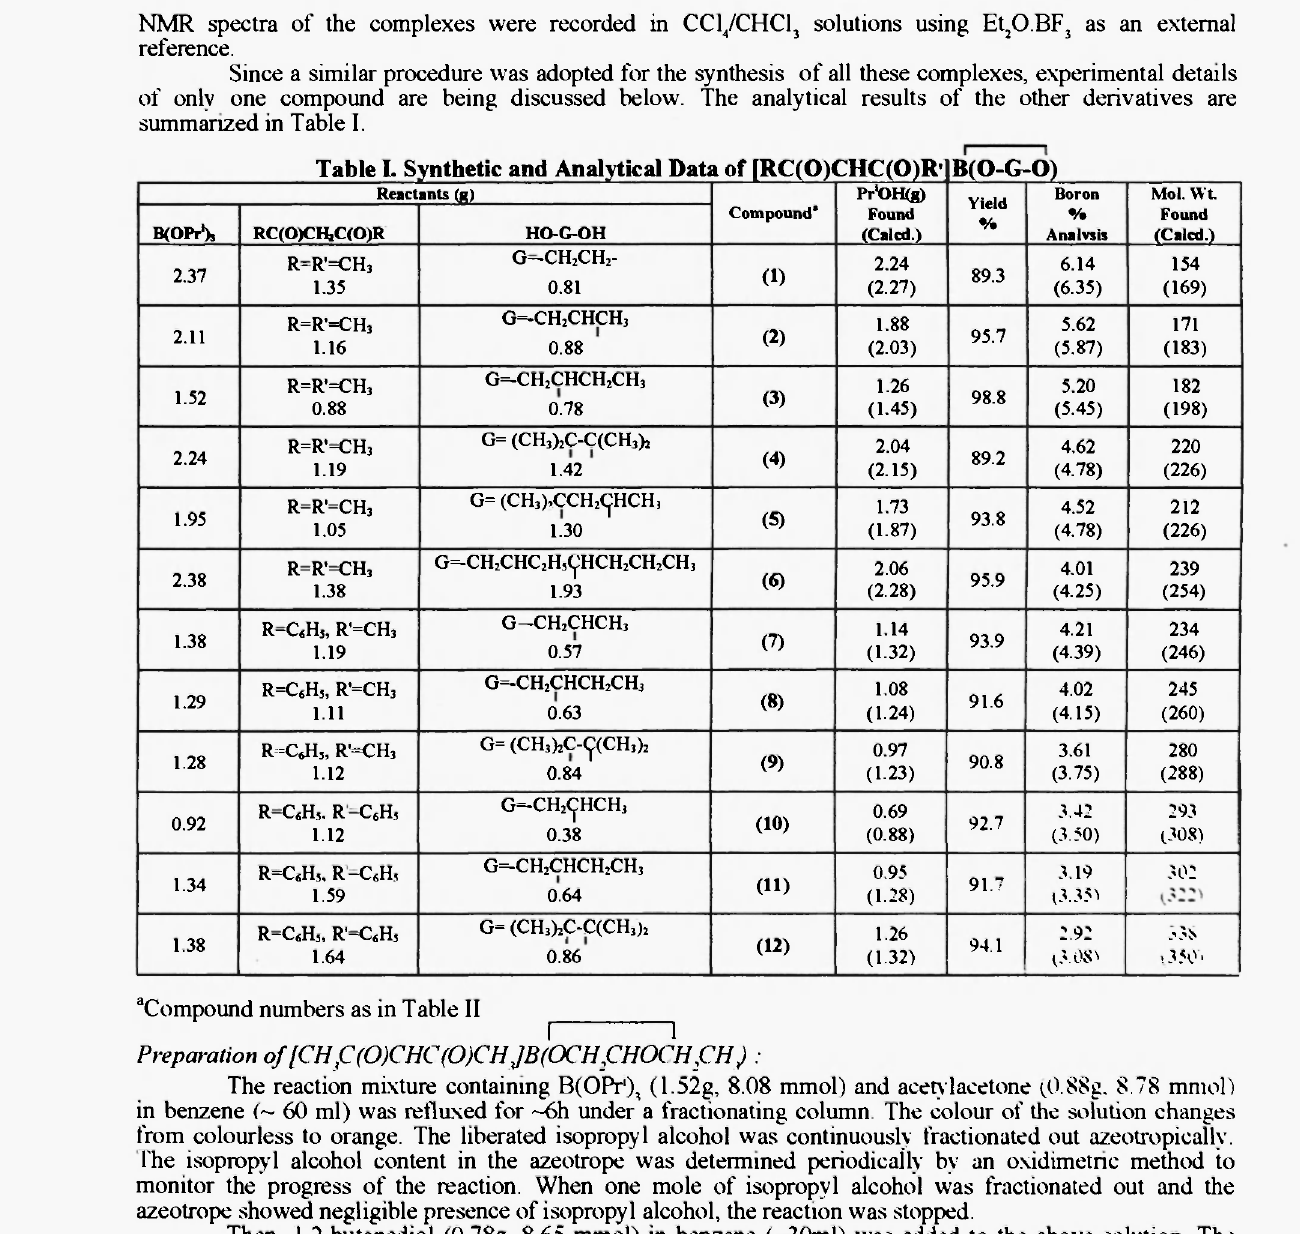
Table L Synthetic and Analytical Data of [RC(Q)CHC(Q)R lB(O-G-O) Reactants